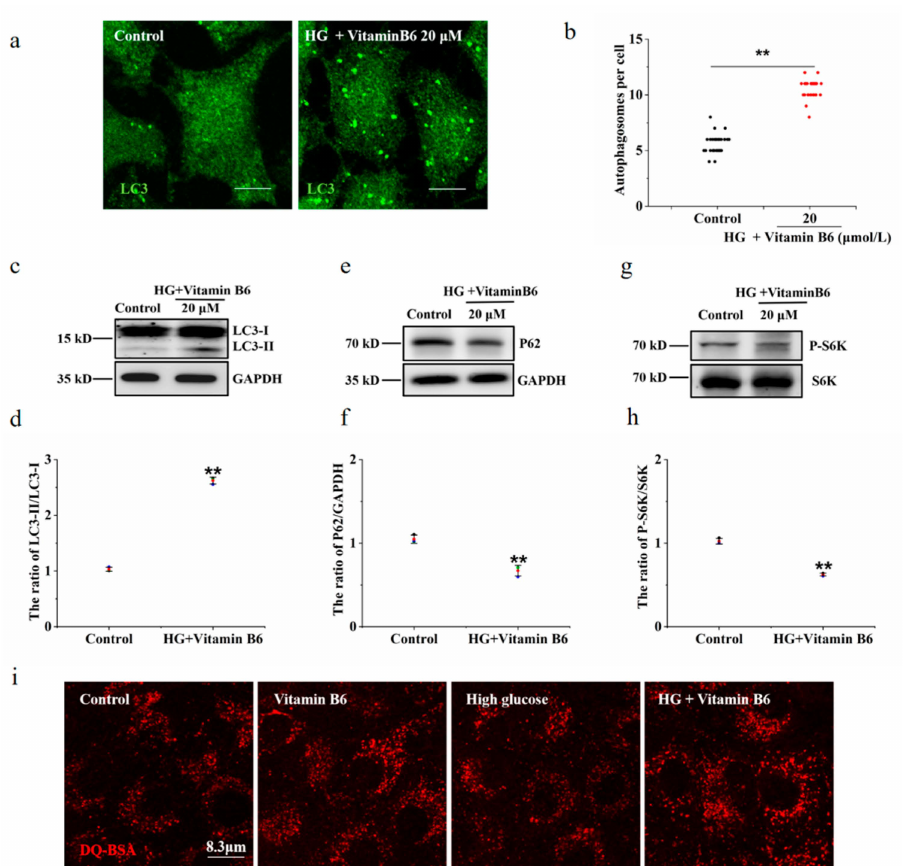
Figure 5. Vitamin B6 induced autophagy under high glucose stress. ( a ) Cells were treated with or without 20 µ M vitamin B6 plus 20 mM glucose (HG) for 36 h, and the number of autophagosomes was assayed by immunofluorescence analysis. ( b ) Cells were treated as described in ( a ), mathematical statistics were performed to calculate the number of autophagosomes per cell, and at least 30 cells were counted by t -test analysis. The experiment was repeated at least three times. ( c , e , g ) Cells were treated as described in ( a ), and Western blotting was performed to test the expression of proteins with specific anti-p62, anti-S6K, anti-p70S6K, anti-LC3, and anti-GAPDH antibodies. ( d , f , h ) The ratio of LC3-II/LC3-I, P62/GAPDH, and pS6K/S6K ratios in ( c , e , g ), respectively, were analyzed by IOD using Image-Pro Plus 6.0 software (Error bars, SD. ** p < 0.01, indicates significant differences compared with the control group). ( i ) The cells were treated with or without glucose (HG), with vitamin B6 or with 20 µ M glucose (HG) plus vitamin B6 for 36 h. The cells were then incubated with DQ-BSA for 3 h and imaged by confocal